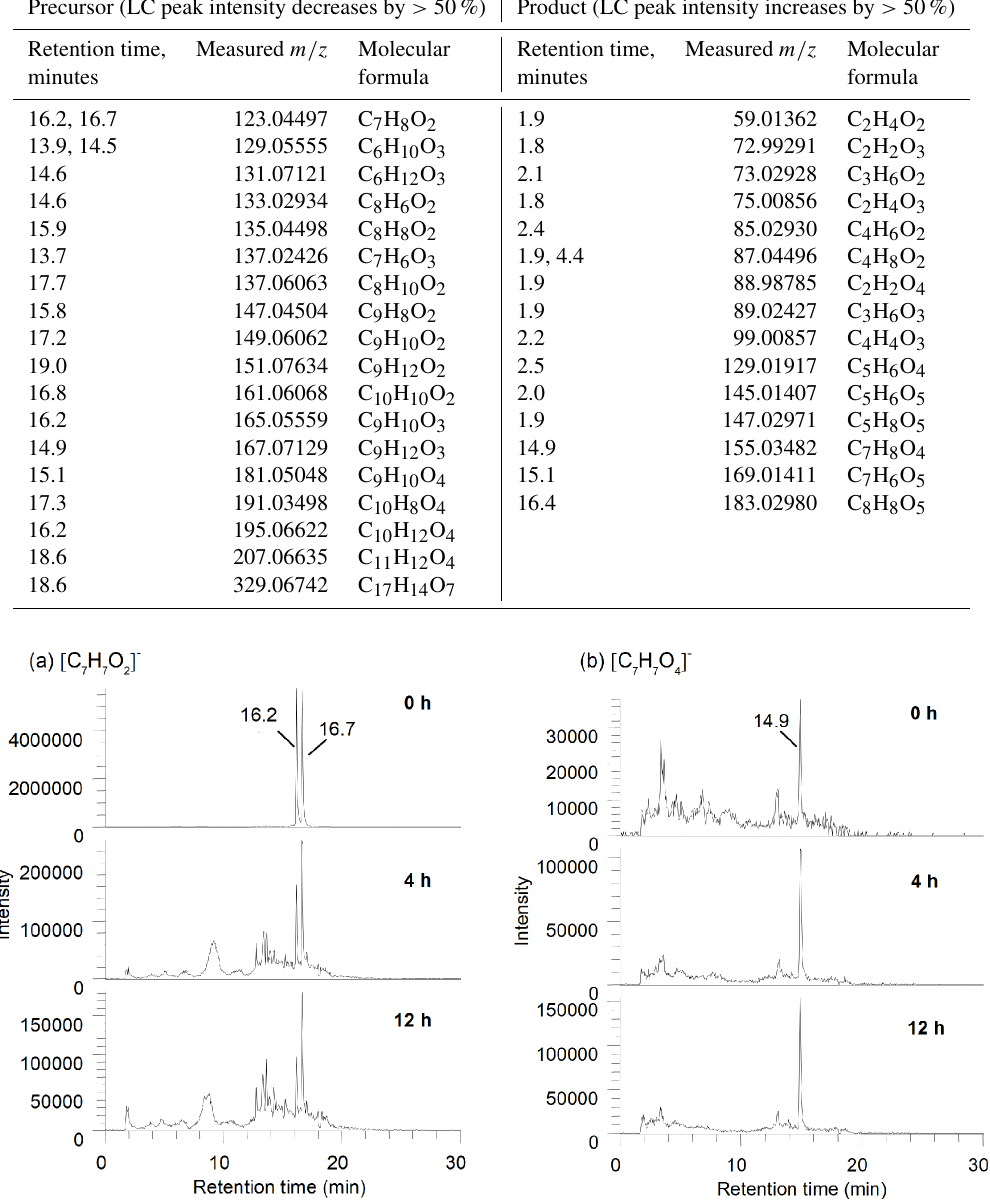
Table 1. m/z with significant changes upon 12h photolysis analysed by LC/ESI-HRMS. Precursor (LC peak intensity decreases by > 50%) Product (LC peak intensity increases by > 50%) Retention time, Molecular Retention time,